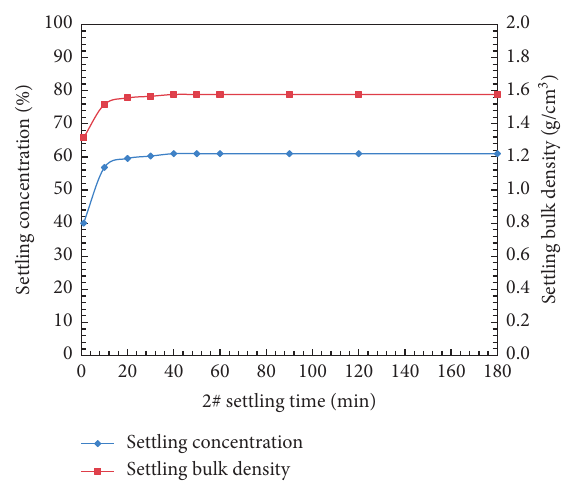
Figure 8: Variation curves of flocculation settling concentration and bulk density (#3). Figure 8. The settling bulk density increased gradually and